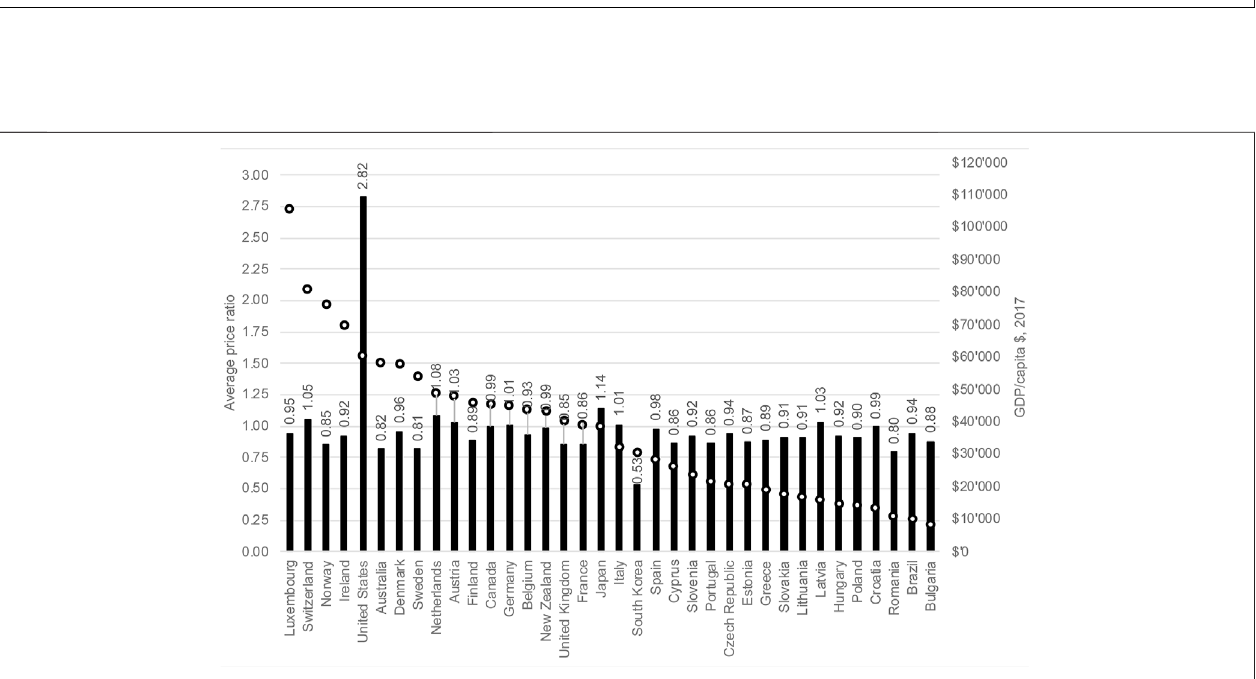
FIGURE 1 | ERP affordability (mis)match map — how far is each country setting its prices based on a country basket of similar affordability Notes: United States data are two hypothetical counterfactuals, based on recent government proposals: United States1 calculated as per “ Ways and Means ” (2019) (Ways and Means Committee, 2019); United States2 calculated as the maximum of “ CBO ” (2021) (Congressional Budget Of fi , 2021); Canada calculated with rules planned to be valid as of 2022.